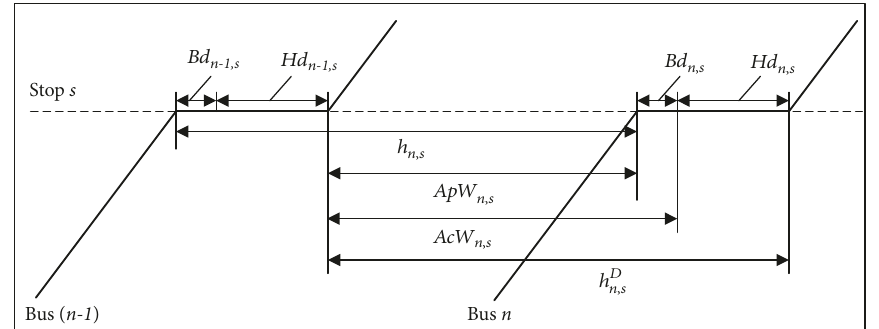
Figure 1: Illustration of passenger waiting time at